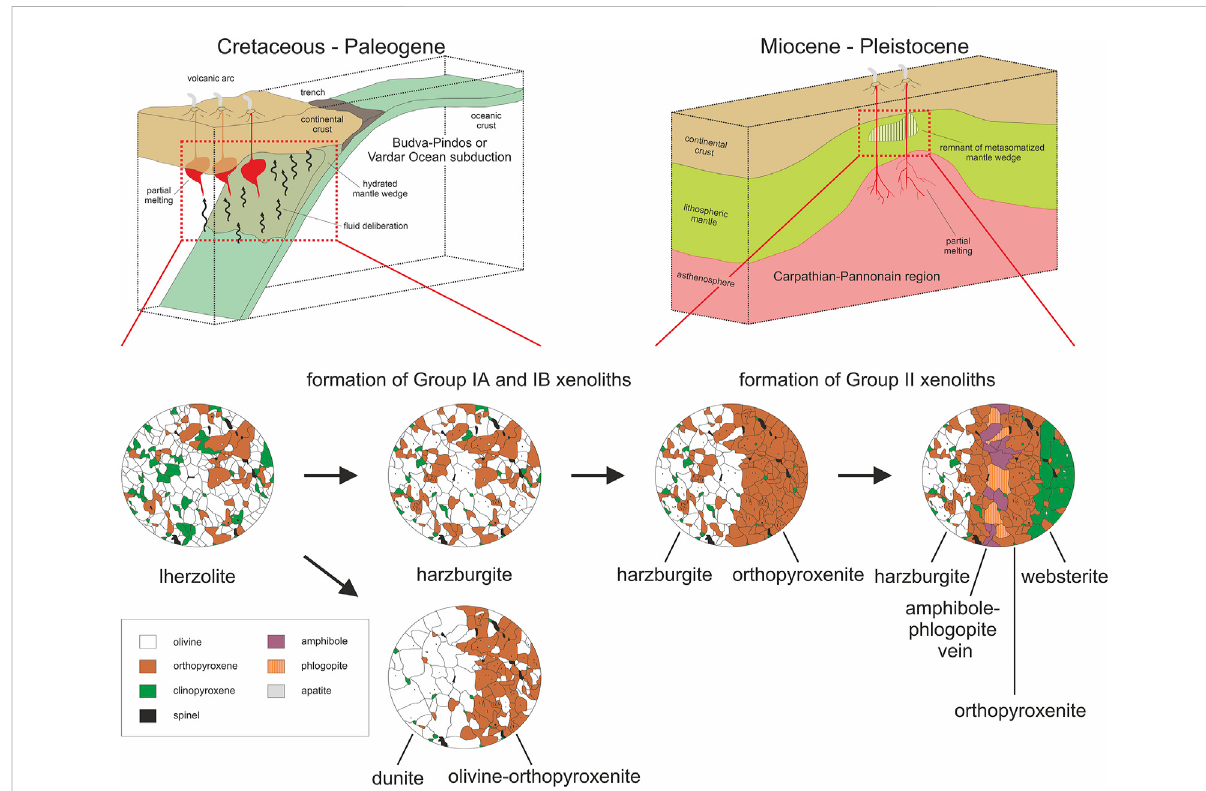
FIGURE 11 Simpli fi ed cartoon showing the proposed lithospheric mantle evolution model beneath the western Carpathian-Pannonian region. The Cretaceous-Paleogene tectonic stage includes the formation of Group IA and IB harzburgite, olivine-orthopyroxenite and dunite lithologies in a mantle wedge environment related either the Budva-Pindos or Vardar Ocean subduction. This geodynamic stage was followed by the upward migration of asthenosphere-derived ma fi c melts in the Miocene-Pleistocene leading to the formation of Group II xenoliths having orthopyroxenite, websterite and amphibole-phlogopite veins. Lherzolite lithology from MSZK xenolithseries isonly described inCréon etal.,